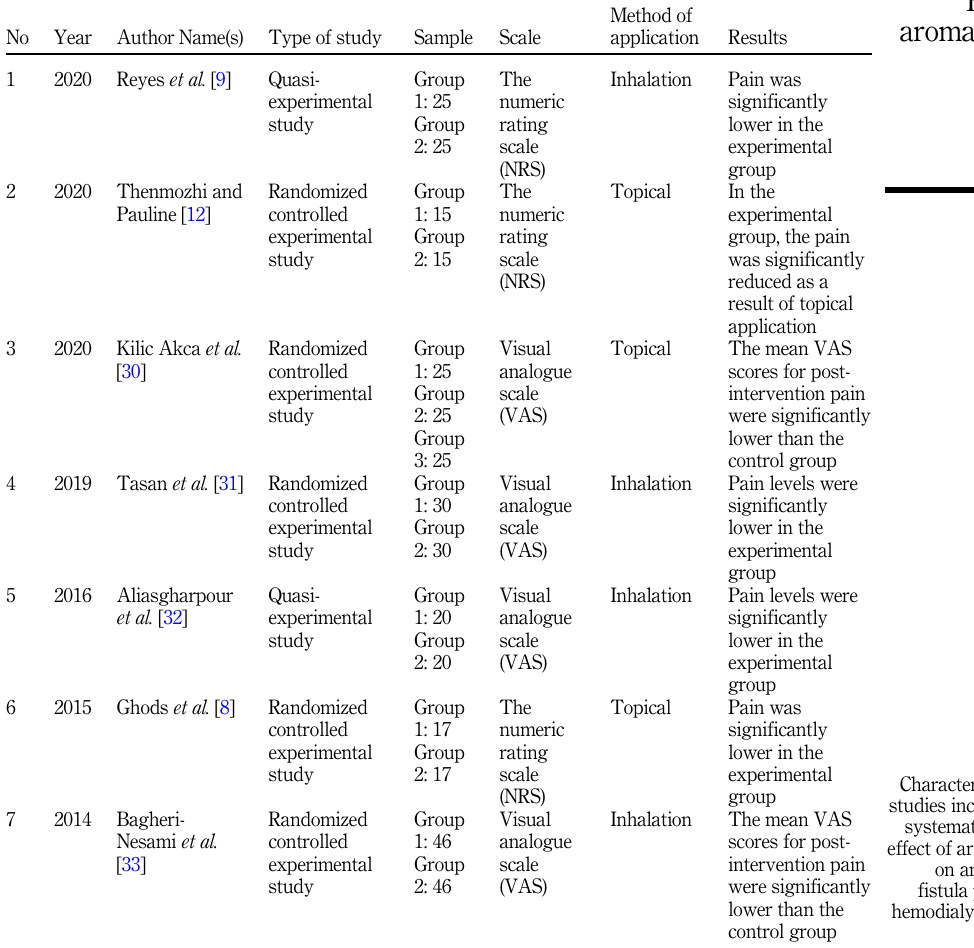
Table 3. Characteristics of